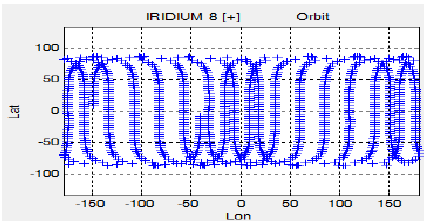
Figure 8. The schematic view of the path of the Iridium satellite Based on the celestial coordinates of stars obtained from a star catalogue and the prediction pass of the satellites and taking into account optical factors, sequences images are generated as Figure 9.